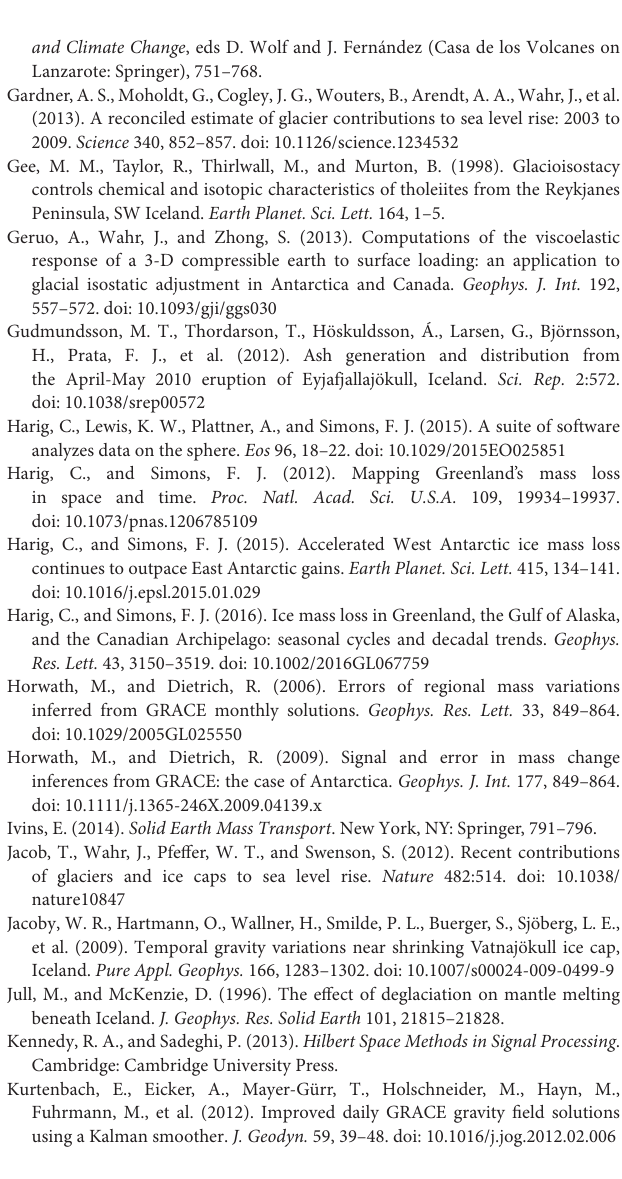
Supplementary Figure 1 | Two optimal Slepian functions describing mass changes over